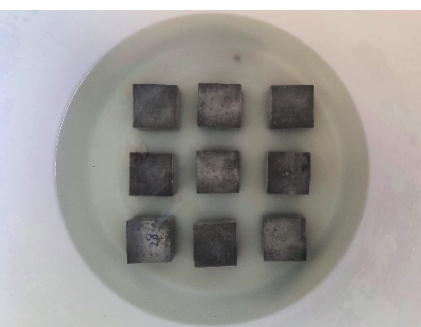
Figure 2: Concrete specimens immersed in sulfate solution.